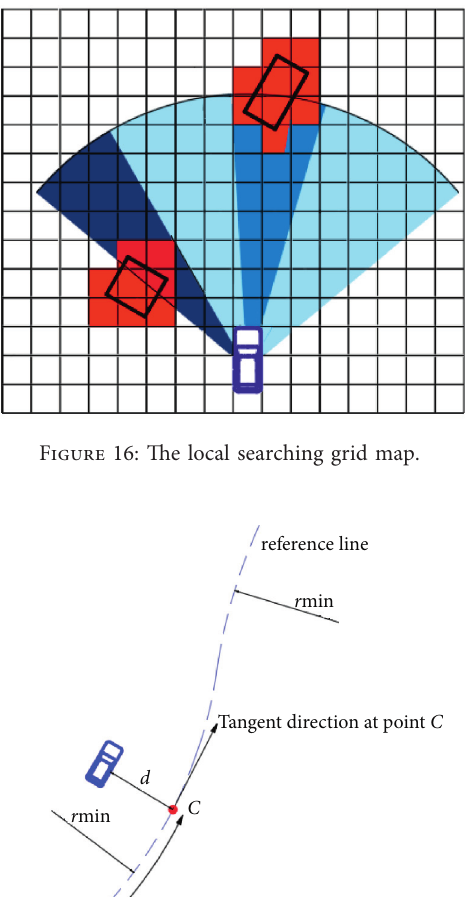
Tangent direction at point C